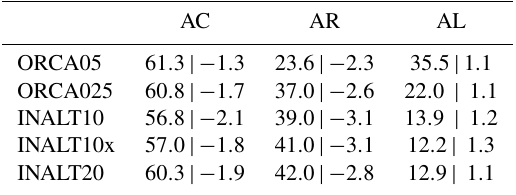
Table 11. Mean (1995–2005) transport (in Sv) and linear trends from 1965 to 2000 (in Sv per decade) for the Agulhas Current (AC), Agulhas Return Current (AR) and Agulhas leakage (AL) as simu- lated in the Lagrangian